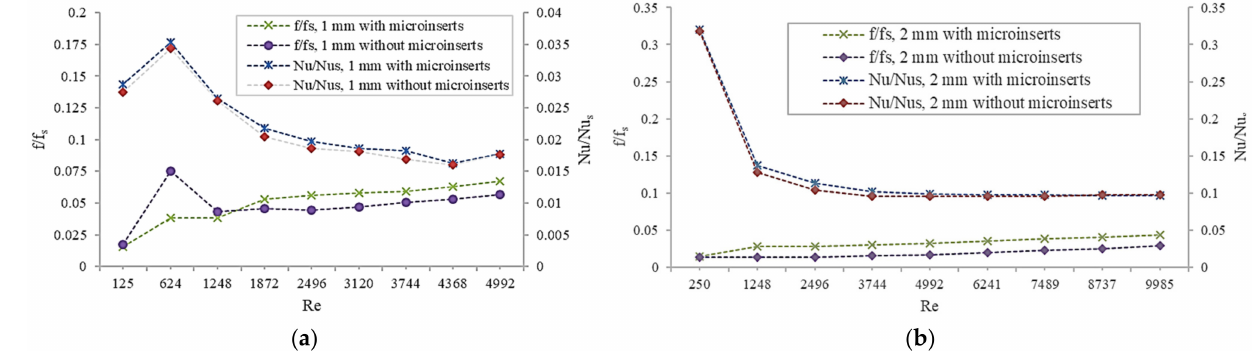
Figure 7. Variation in f/f s and Nu/Nu s with Reynolds number for ( a ) 1 mm and ( b ) 2